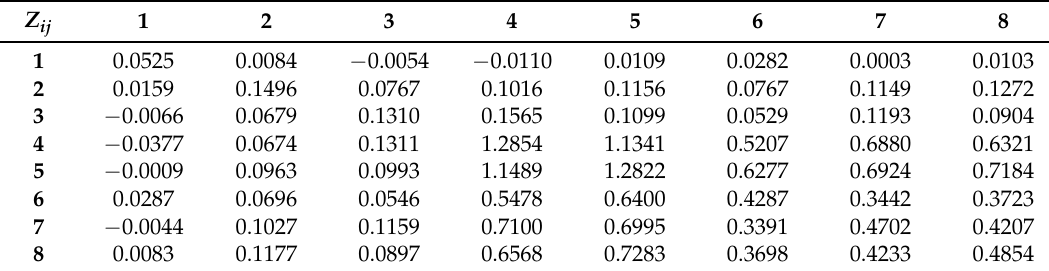
Table 1. Transfer matrix of the lower left plate.